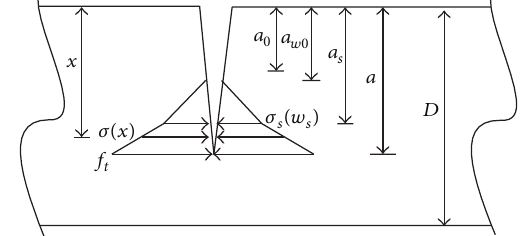
Figure 6: Crack propagation stage